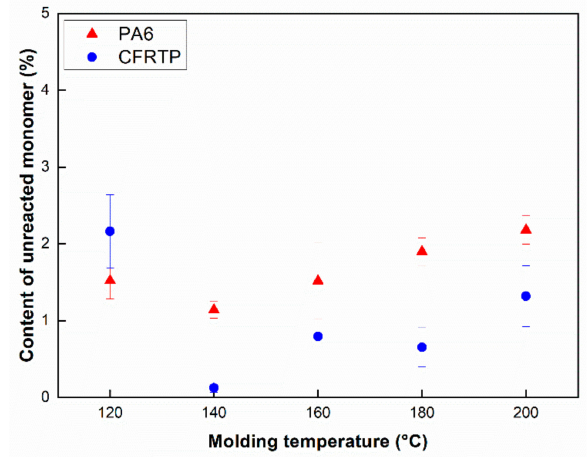
Figure 3. Unreacted monomer content of the pure PA6 and CFRTP composites.